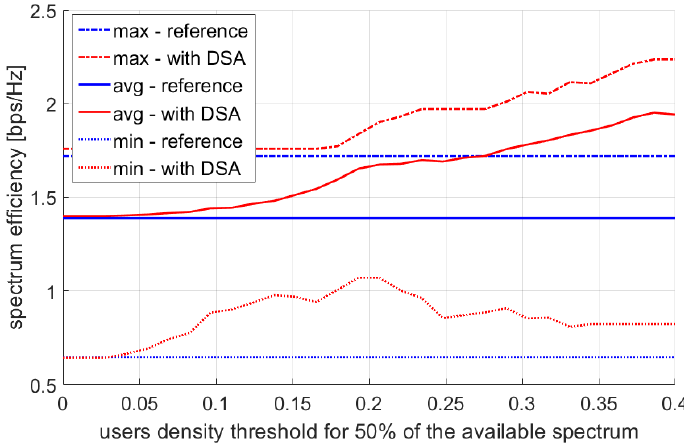
Figure 10. Multiple simulation repetition results—spectrum efficiency.